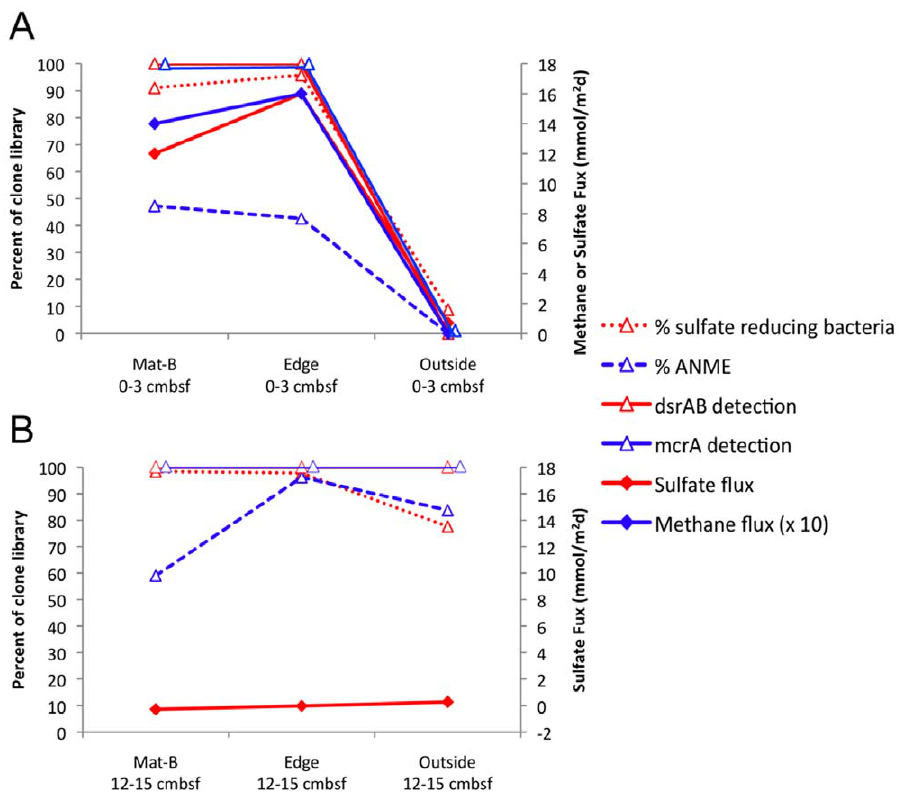
Figure 6. Correlation of geochemical and microbial stratification. Comparisons of geochemical fluxes and molecular microbiological data for three cores within a bacterial mat (Mat-B), at its edge (Edge), and less than a meter outside the mat (Outside). Plotted are percent of bacterial clones from putative sulfate reducing bacterial rRNA transcripts; percent of archaeal clones from putative methane oxidizer/methanogen ANME groups; presence or absence of dsrAB and mcrA mRNA clones (100%) or absence (0%), slightly offset from each other for visibility; the absolute value of the sulfate flux, since all were negative values; and methane flux multiplied by 10. Sulfate-related data is shown in red, and methane-related data is shown in blue. A) data for surface sediments (0–3 cmbsf), B) data for deeper sediments (12–15 cmbsf). Methane fluxes could not be accurately calculated for B) because methane concentrations were above atmospheric saturation and were not reliable.